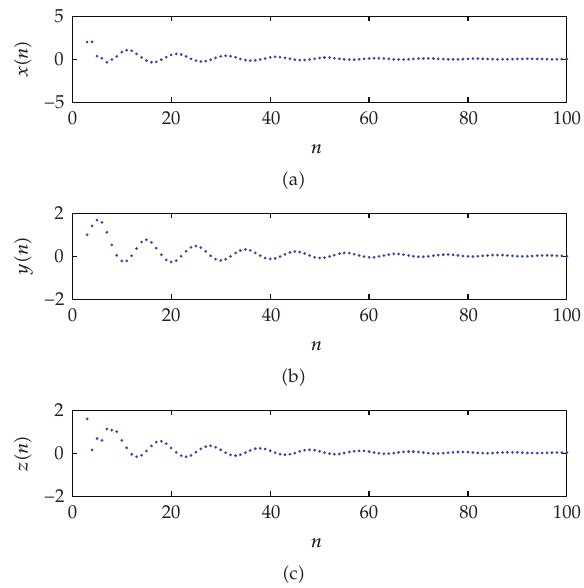
Figure 1: The origin is local asymptotically stable for parameters a (cid:8) 0 . 5 , α (cid:8) 0 . 48 , and β (cid:8) − 0 . 18